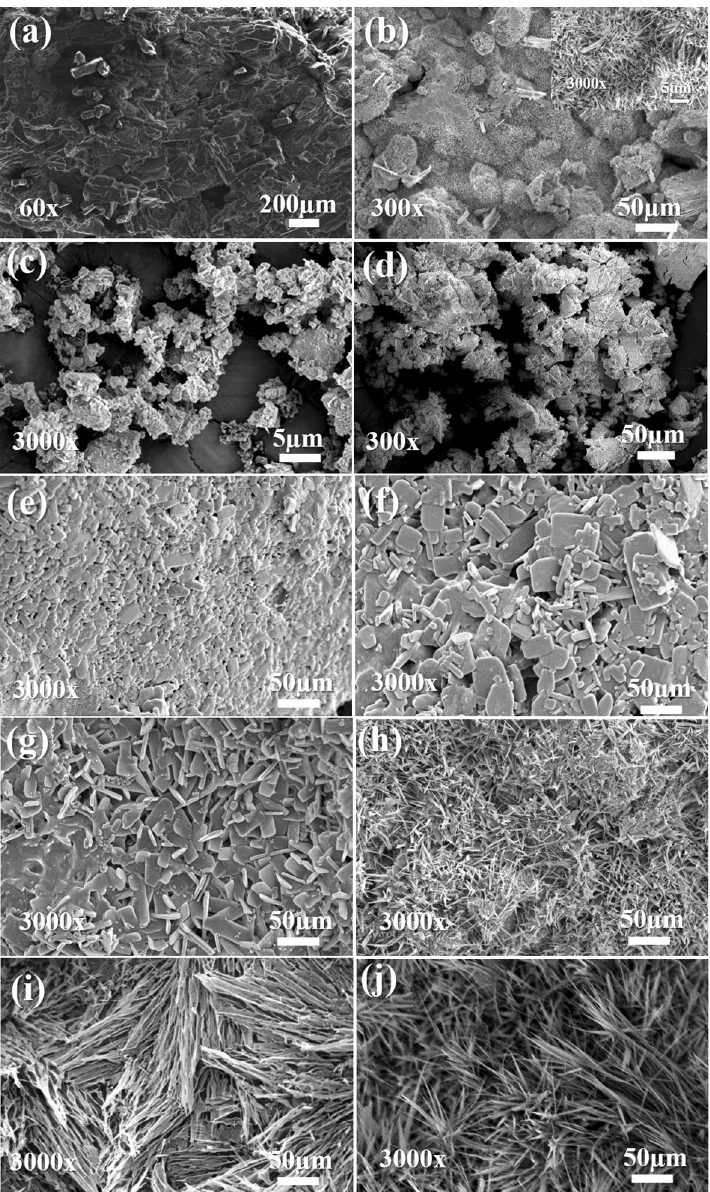
Figure 1. SEM images with its magnifications of ( a ) pure urea, ( b ) pure polymer UF, ( c ) ZnO, ( d ) ZnSO 4 , ( e ) UFZO 0.5, ( f ) UFZO 1, ( g ) UFZO 2, ( h ) UFZS 0.5, ( i ) UFZS 1 and ( j ) UFZS 2. (UF = pure polymer, UFZO = composites with ZnO and UFZS composites with ZnSO 4